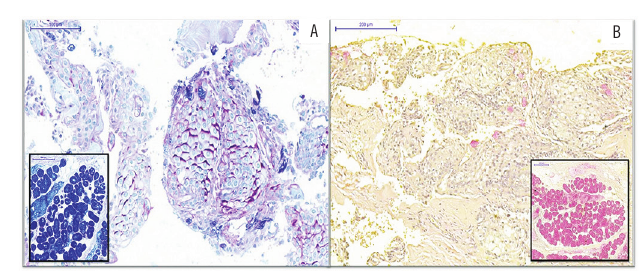
figurE 4 − Histochemistry A) alcian blue-PAS; B) mucicarmin. PAS: periodic acid Schiff.